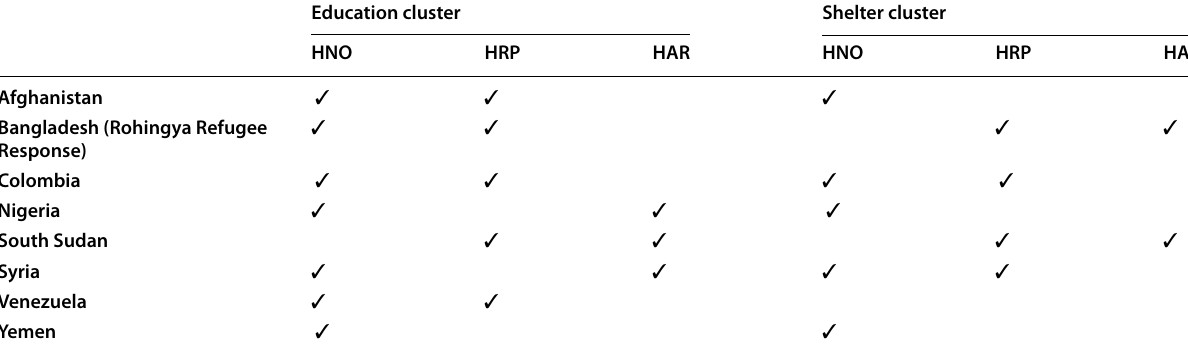
Note: ✓ document identified gender differences and inequalities; HNO Humanitarian Needs Overview; HRP Humanitarian Response Plan; HAR Humanitarian Annual = Report; SADD inclusion of sex and age disaggregated